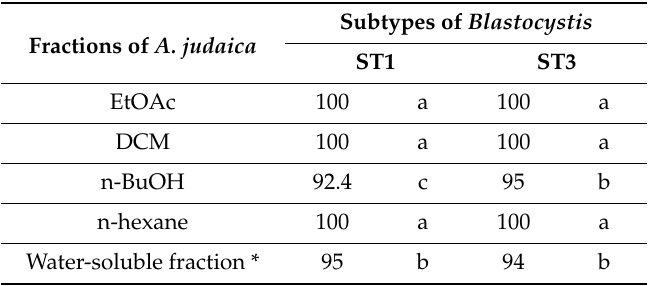
Table 4. Percentage of growth inhibition of Blastocystis in cultures challenged with fractions of A. judaica (100 µ g / mL) against ST1 and ST3 Blastocystis